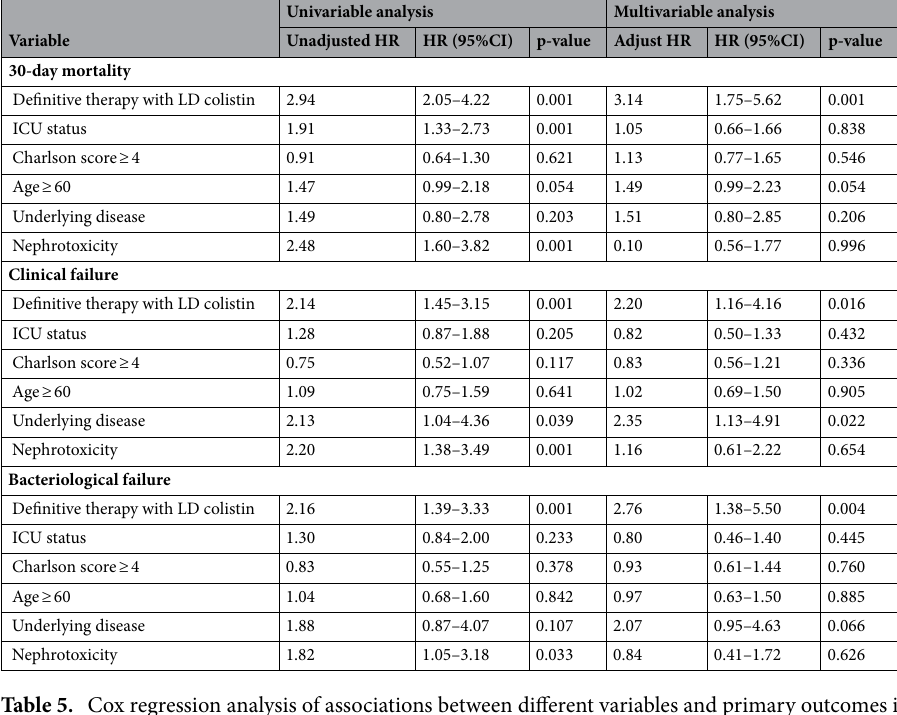
Table 5. Cox regression analysis of associations between different variables and primary outcomes including 30-day mortality, clinical response and bacteriological response. CI, confidence interval; HR hazard ratio.